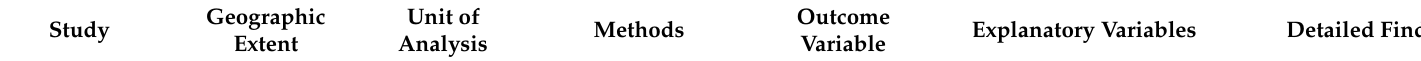
Table A2. Methodological details for theme 1